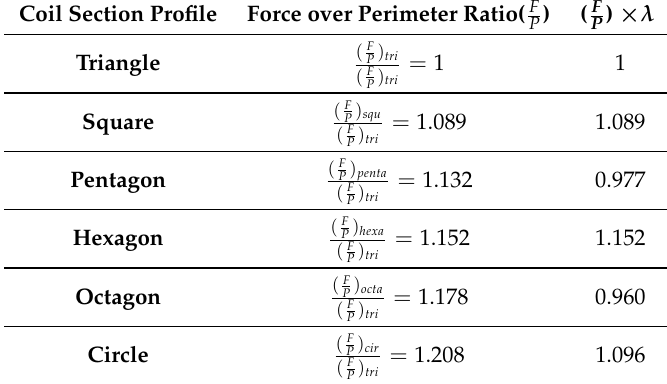
Table 5. Comparison of the produced magnetic fields and the forces among various coil cross-section